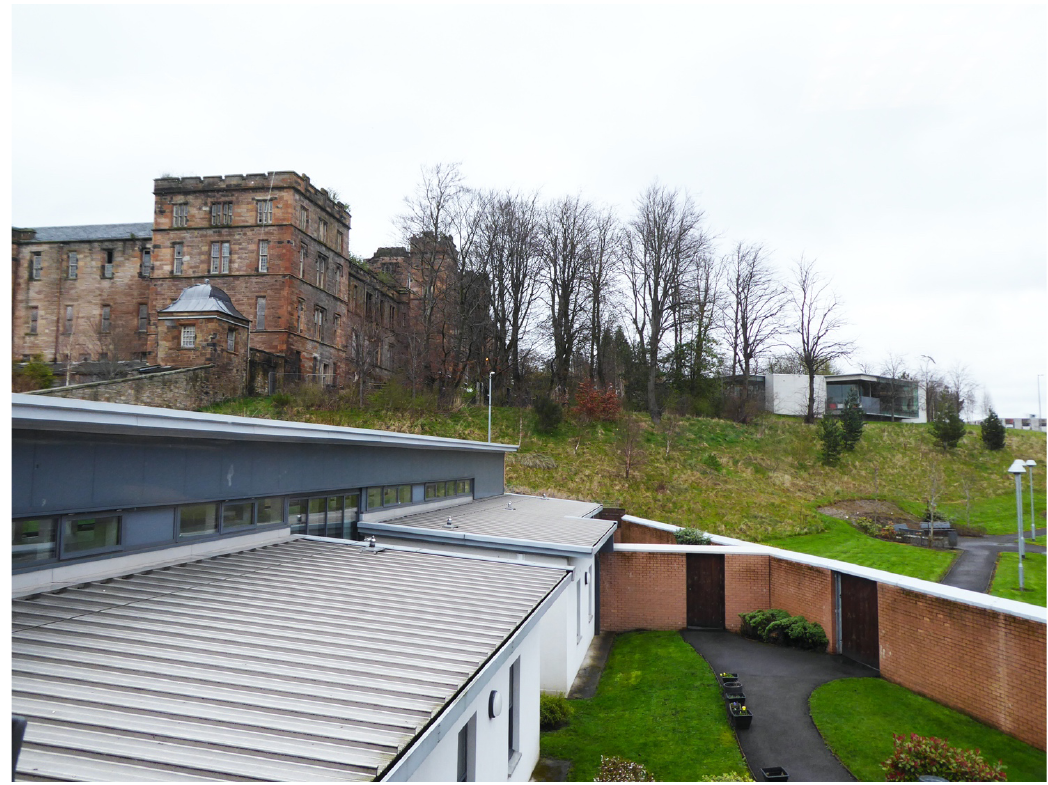
Figure 4. View from NGRH towards ‘old asylum’ on the hill and its empty and derelict East House. To the right, behind a curtain of mature trees, Glasgow’s Maggie’s Centre (opened 2011) is crouching. Source: Ebba Högström.